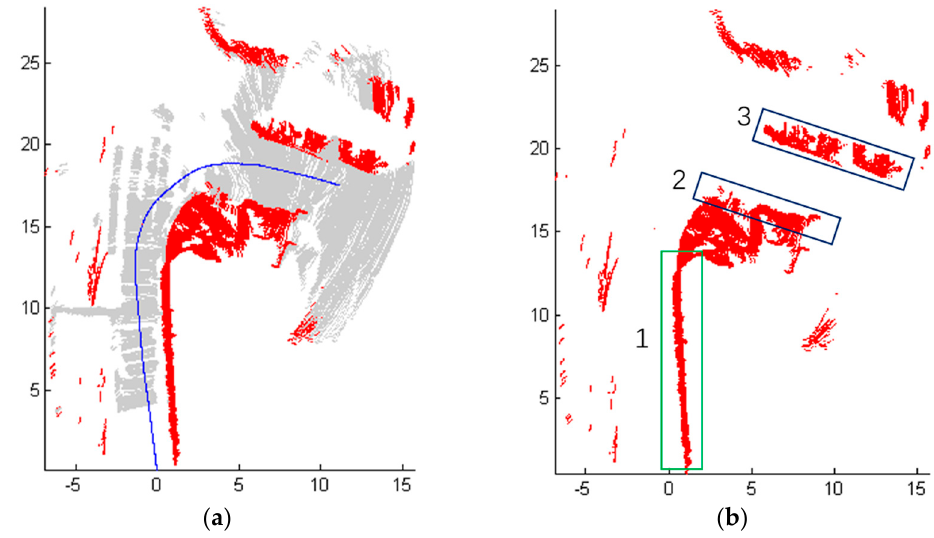
Figure 9. Obstacle detection results of Scene 2. ( a ) Results of obstacles detection; ( b ) The position of some obstacle area.